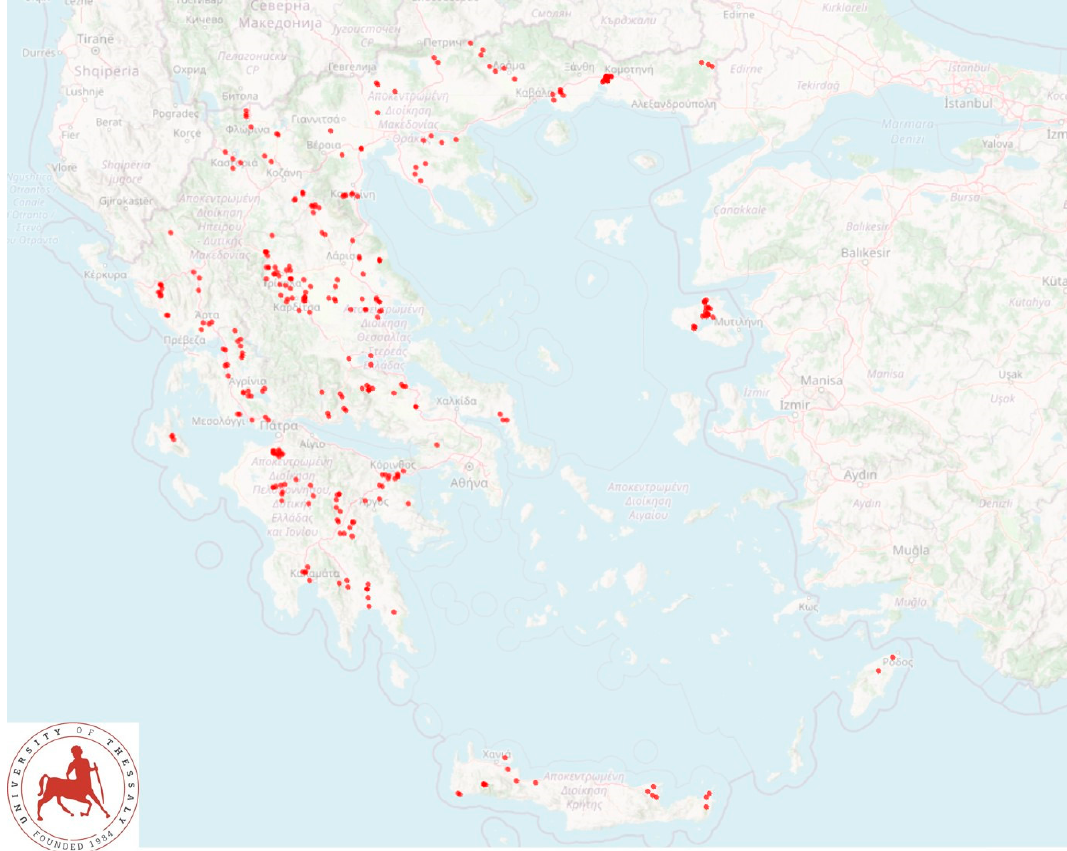
Figure 1. Location of 325 sheep flocks around Greece, which were visited for bulk-tank milk sampling.